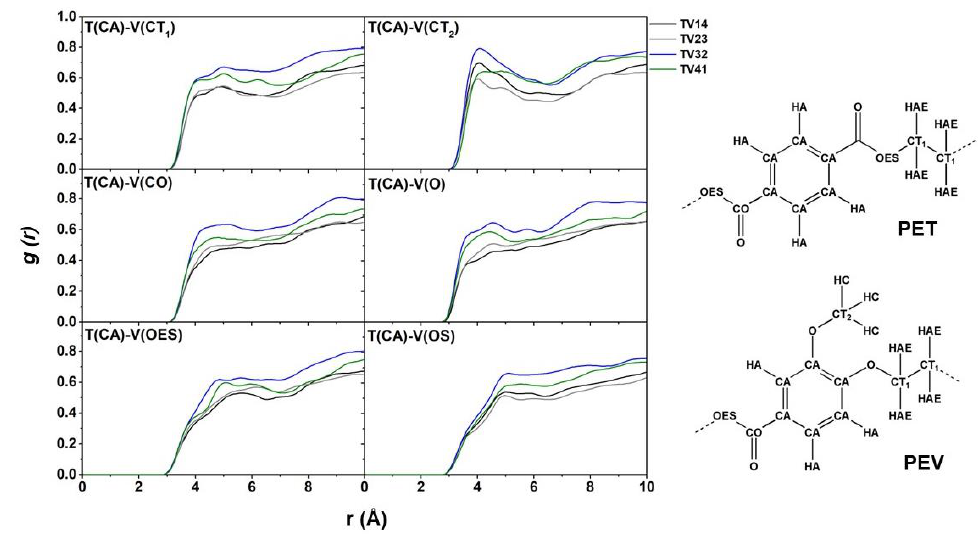
Figure 6. The site–site RDFs, g(r) , of PET chains are centered on the CA atom of the polymer benzene ring and extend to the CT ethylene carbons and the ester components CO, O, and OES of PEV chains.